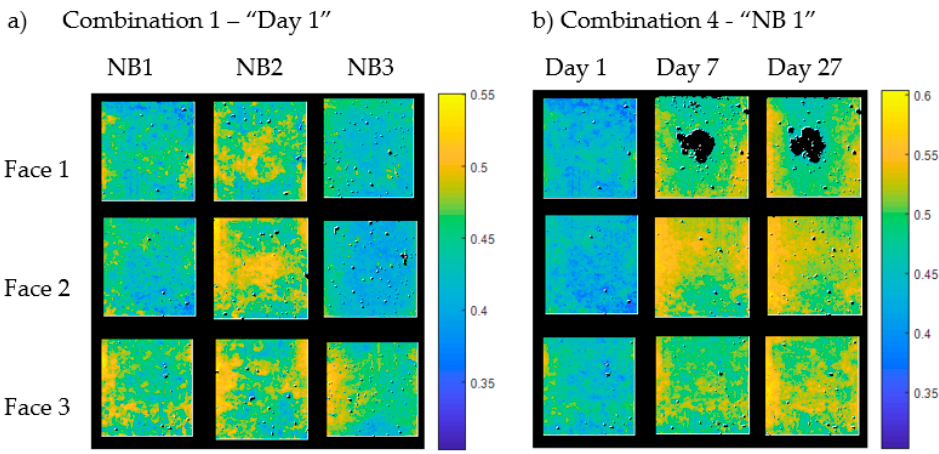
Figure 4. Merged images for statistical analysis of ( a ) combination 1 and ( b ) combination 4